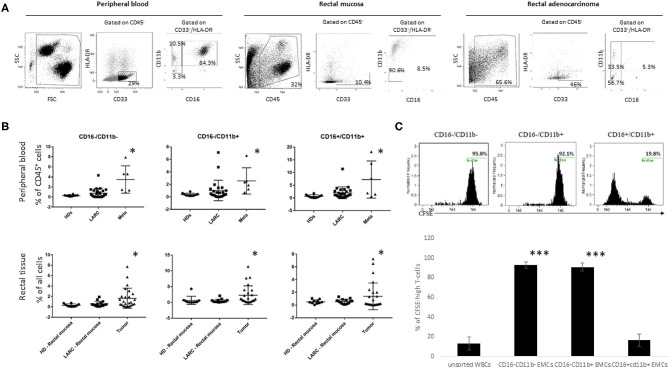
CD16−CD11b−/+EMCs levels are increased in tumor but not peripheral blood of LARC patients, and bear immunosuppressive capabilities. The different EMCs subpopulations are presented by the percentages of HLA-DR−CD33+CD16−CD11b−/+ of the entire peripheral blood or tissue population. (A) representative pictures of the three different EMCs populations (CD16−CD11b−, CD16−CD11b+, CD16+CD11b+), gated from CD33+HLA-DR− population from peripheral blood, Normal mucosa, and rectal tumor of LARC patients. (B) flow cytometry analysis of the three different EMCs populations mentioned above in the peripheral blood (upper line) of HD (n = 10), LARC patients (n = 25) and metastatic patients (n = 6), and in rectal tissue (lower line) of HD (n = 10), rectal mucosa and rectal tumor in LARC patients (n = 25), *P < 0.05 (C) Flow cytometry analysis of CFSE content in peripheral blood T-cells directly exposed to the different subpopulations of EMCs (Upper row—representative pictures. N = 5 tumors, 10 healthy lymphocyte donors, ***P < 0.005).